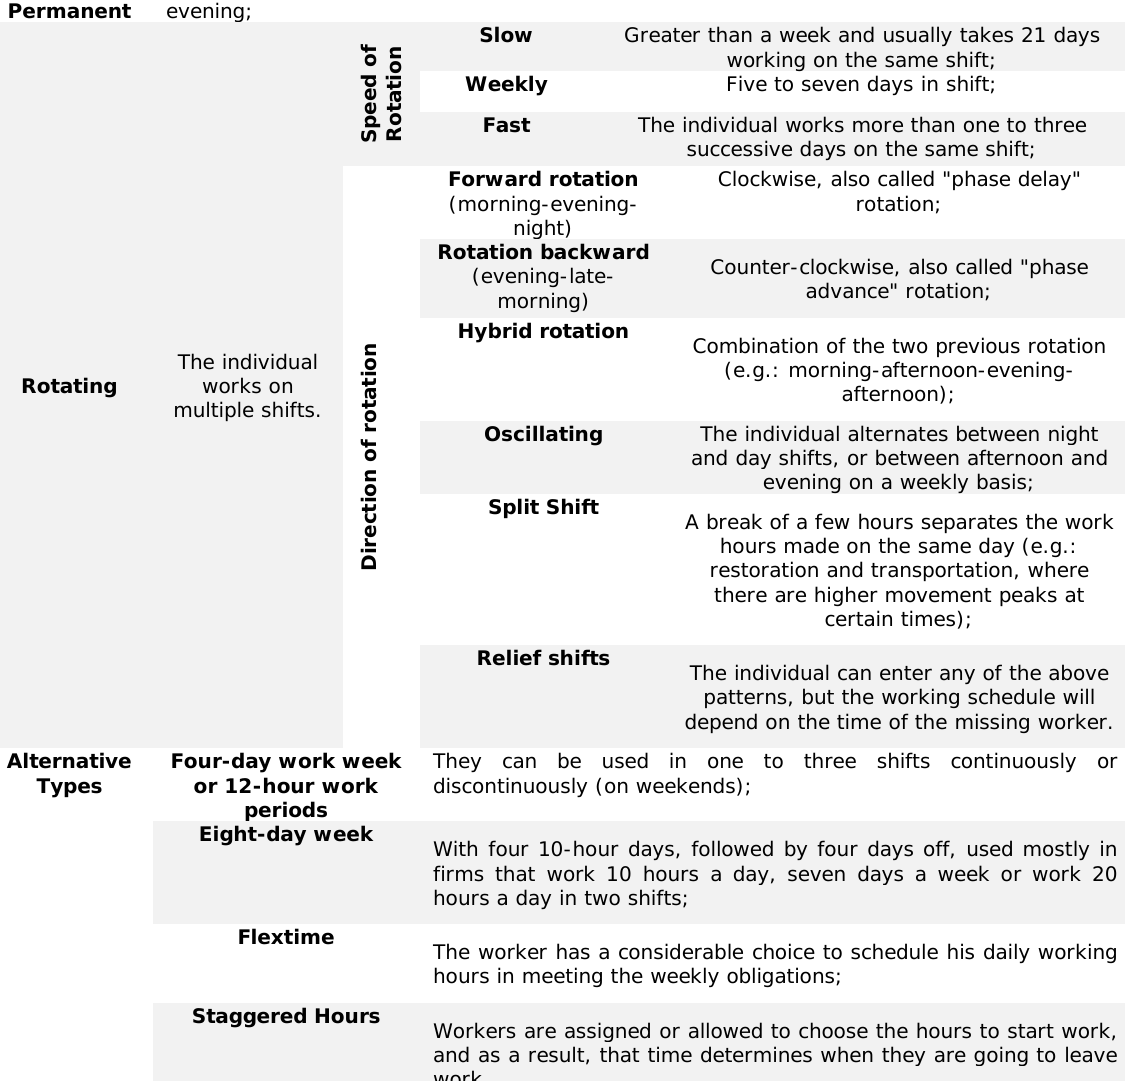
Table 1. Types of shifts (Adapted from: Scott & LaDou (1994) and Silva